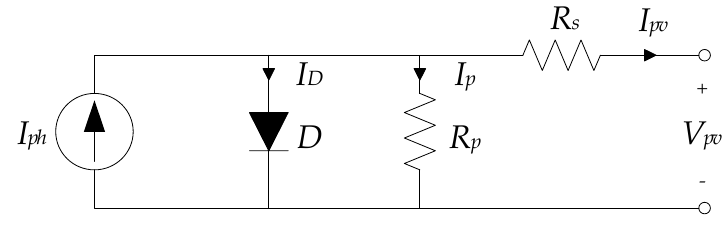
Figure 7. Equivalent circuit of PV cell [118].